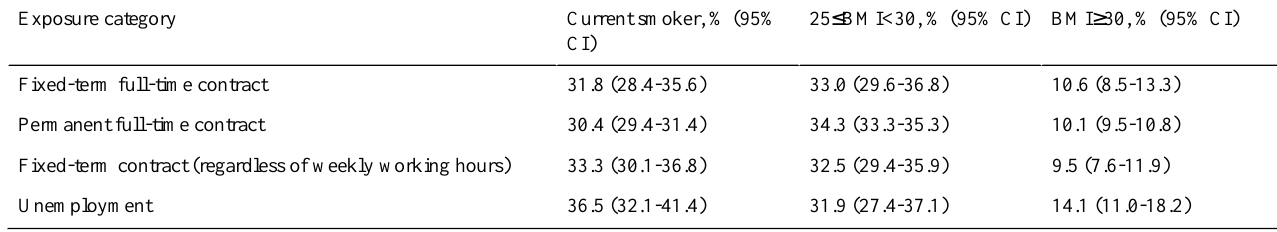
Table 6. Age (10-year classes), gender and education (low, medium, and high) standardized percentages of current smokers, people with moderate overweight (25 ≤ BMI<30), and people with obesity (BMI ≥ 30), by exposure category, in a random sample of 20- to 59-year-old people in Denmark,